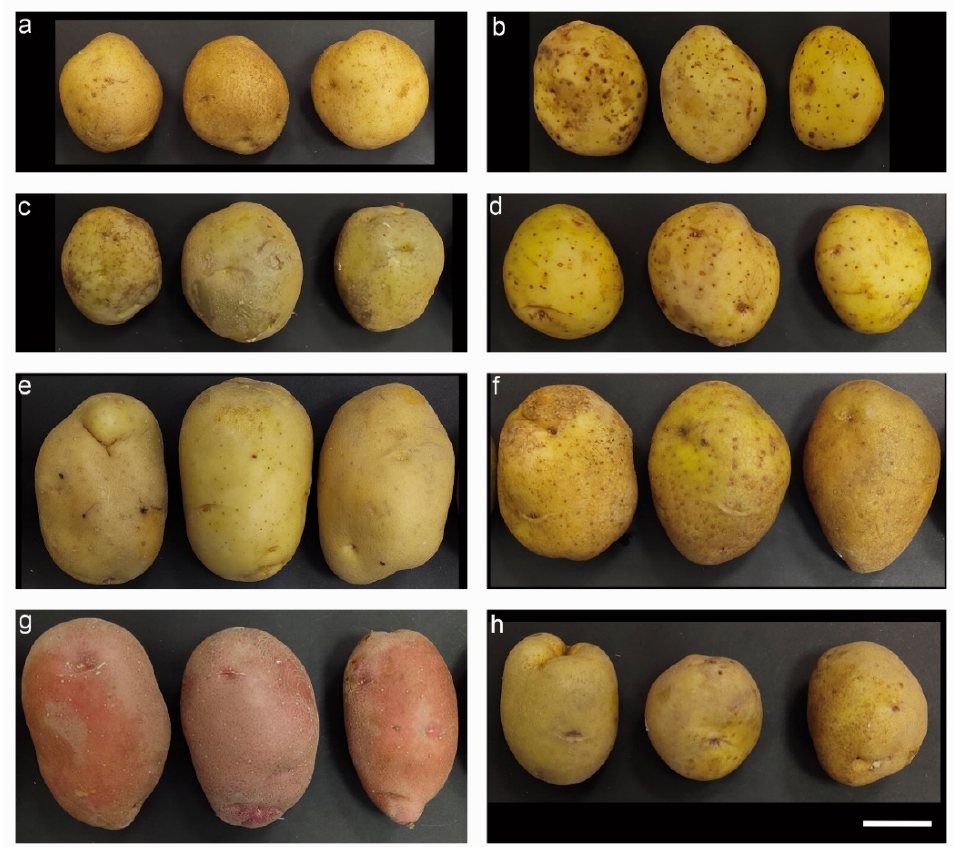
Figure 1. Photos of tubers of potato cultivars used in this study. ( a ), ‘L8’; ( b ), ‘V7’; ( c ), ‘YouJin’; ( d ), ‘TianShu 11’; ( e ), ‘XiSun 6’; ( f ), ‘XinDaPing’; ( g ), ‘QingShu 9’; ( h ), ‘TianShu 12’. Bar = 5 cm.